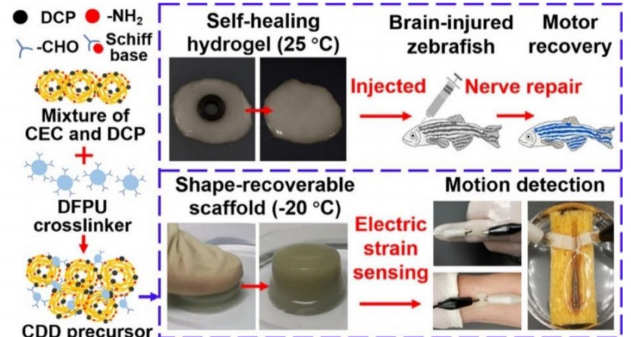
Figure 7. An Injectable, Electroconductive Hydrogel/Scaffold for Neural Repair and Motion Sens- ing [99]. Reproduced with permission from Xu, J, Chem. Mater.; published by American Chemical Society,